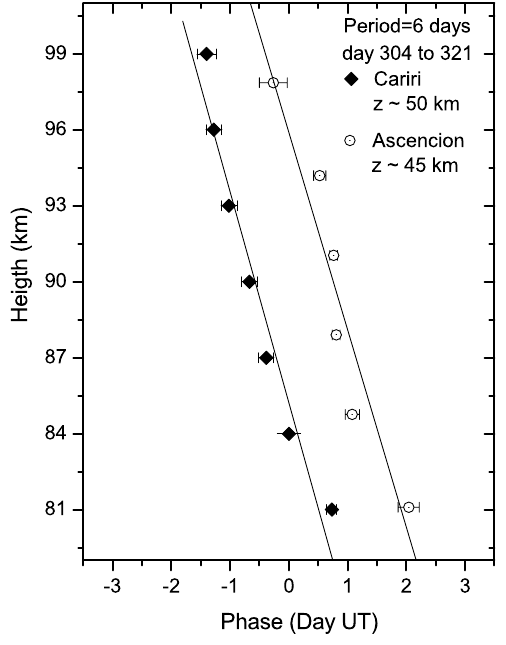
Fig. 8. Phase profiles of the 6-day waves observed in the zonal wind at Cariri and Ascension Island for the period between days 304–321,